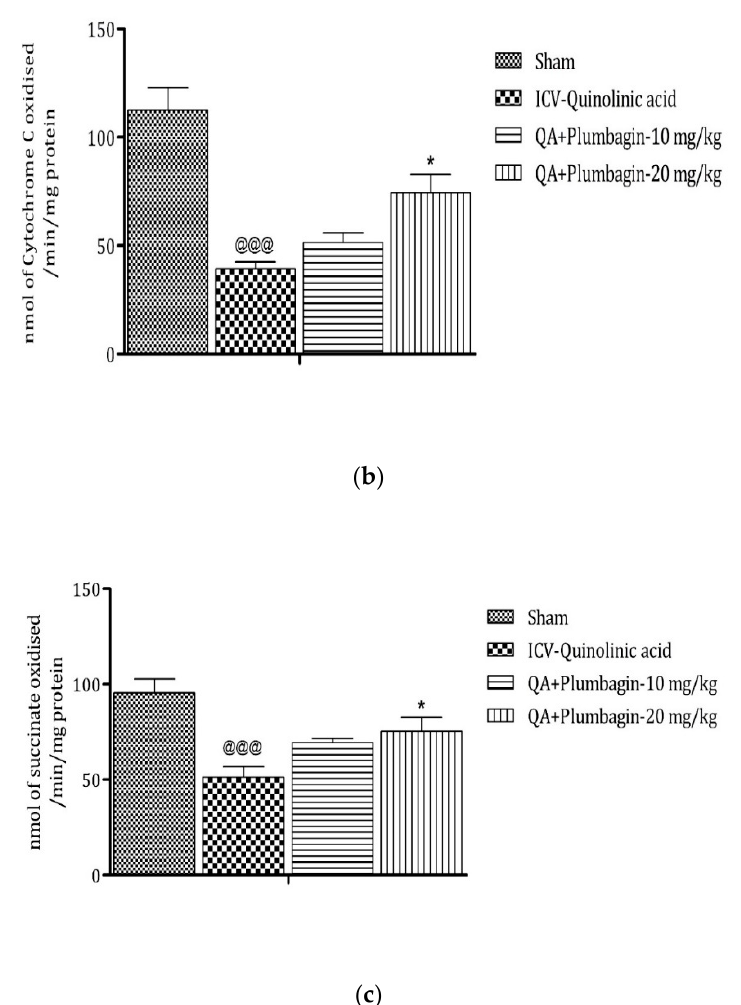
Figure 10. ( a ) Outcome of plumbagin on QA-induced variations in level of Complex I in rats. Data represent mean ± SEM ( n = 6). @@@ p < 0.001 as compared to sham group; *** p < 0.001 as compared to QA-induced group. ( b ) Outcome of plumbagin on QA-induced variations in level of Complex II in rats. Data represent mean ± SEM ( n = 6). @@@ p < 0.001 as compared to sham group; * p < 0.05 as compared to QA-induced group. ( c ) Outcome of plumbagin on QA-induced variations in level of Complex IV in rats. Data represent mean ± SEM ( n = 6). @@@ p < 0.001 as compared to sham group; * p < 0.05 as compared to QA-induced group.